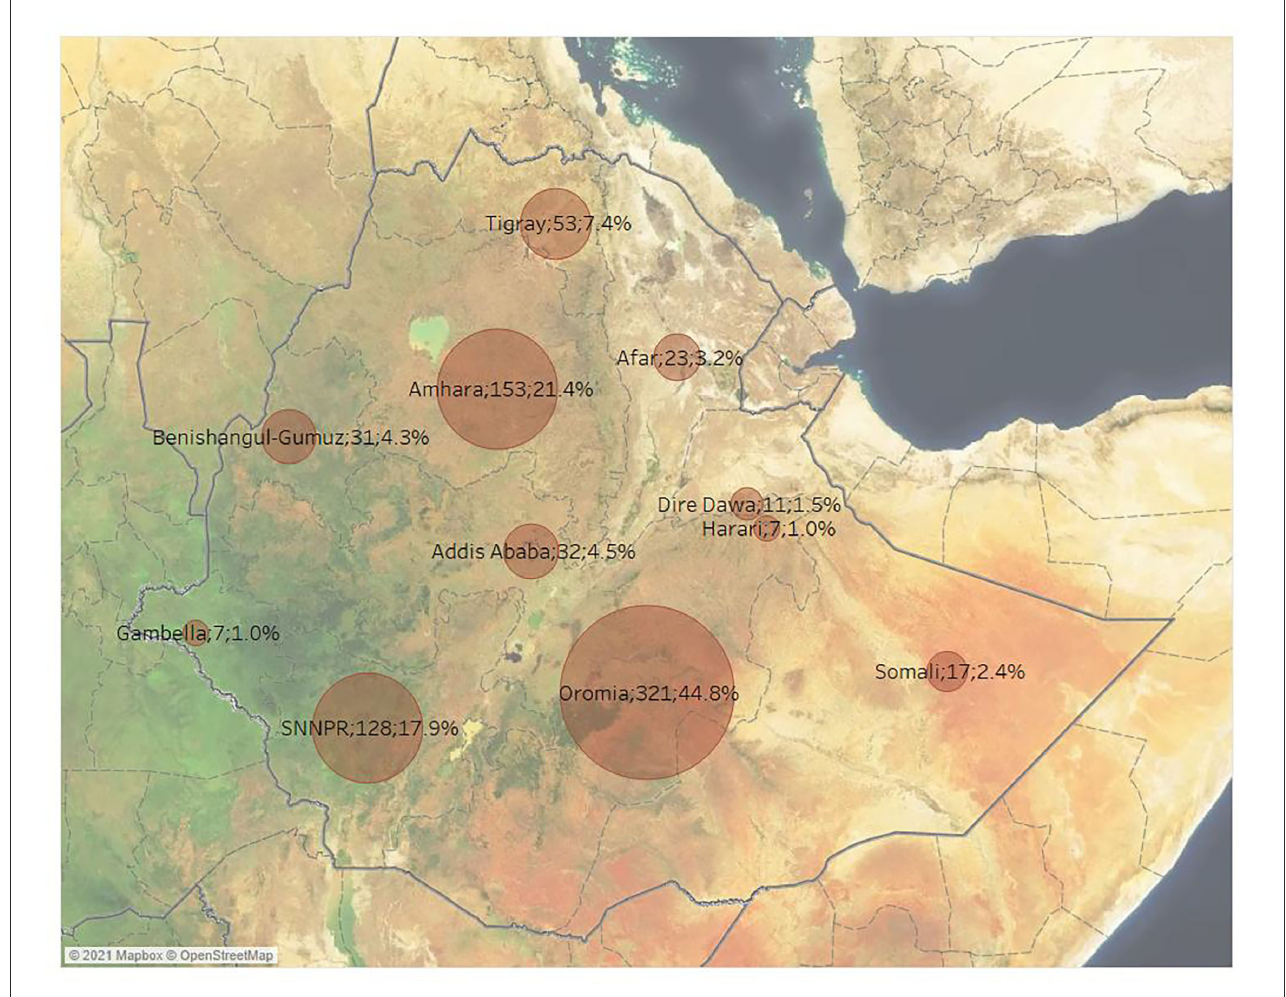
FIGURE5 Number of retrieved studies by geographical region across Ethiopia (some studies included more than one geographical region).